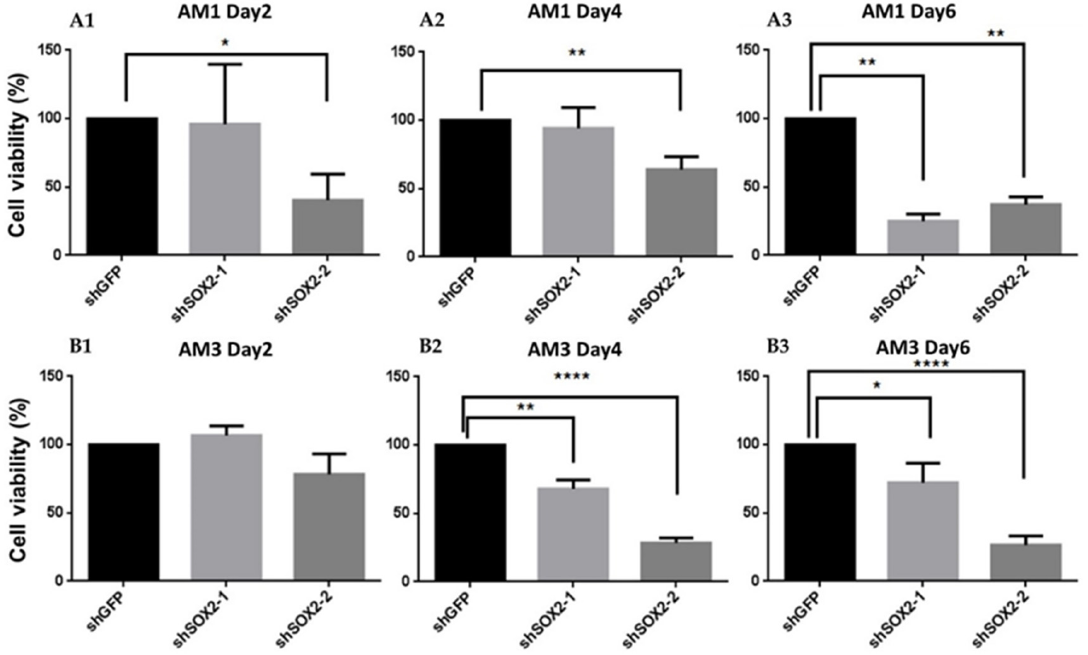
Figure 6. SOX2 knockdown in ameloblastoma cell lines reduces the cell viability. ( A1–3 , B1–3 ) The cell viability of AM1 and AM3 cells at 2 days, 4 days, and 6 days post SOX2 suppression. * p < 0.05; ** p < 0.01; **** p < 0.0001.